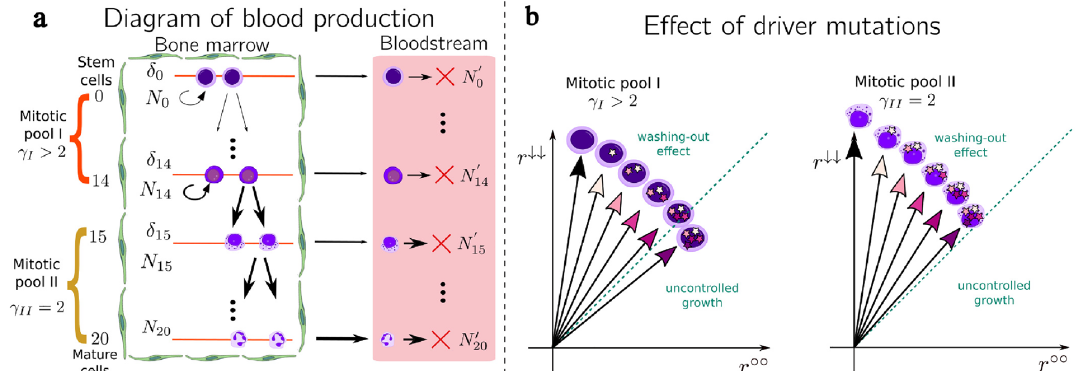
Figure 2. Model of blood production and the effect of driver mutations. ( a ) The bone marrow, represented by the green barrier, is comprised of two pools: mitotic pool I and mitotic pool II. Mitotic pool I contains cells with positive self-renewal rate, including stem cells. Mitotic pool II hosts cells that only produce two more differentiated cells. The horizontal arrows represent cell movement from the bone marrow into the bloodstream. The arrow width corresponds to the intensity of the cell flow. Cells in the bloodstream die with a fixed death rate per cell, represented by the red cross. ( b ) In the diagram, the horizontal and vertical components correspond to the self-renewal rate per cell and the symmetric differentiation rate per cell, respectively. Each driver mutation increments the self-renewal rate and decreases the symmetric-differentiation rate. The accumulation of driver mutations reduces the washing-out effect of the hierarchy, leading to a self-sustainable cell group. These self- sustainable cells do not require cell input from the level above. Wild-type cells in mitotic pool I require fewer driver mutations to overcome the washing-out than cells in mitotic pool II due to the former having a non-zero initial self-renewal rate. This figure has been adapted from the original By A. Rad and M. Häggström. https:// en. wikip edia. org/ wiki/ Haema topoi esis CC-BY-SA 3.0 license, used with